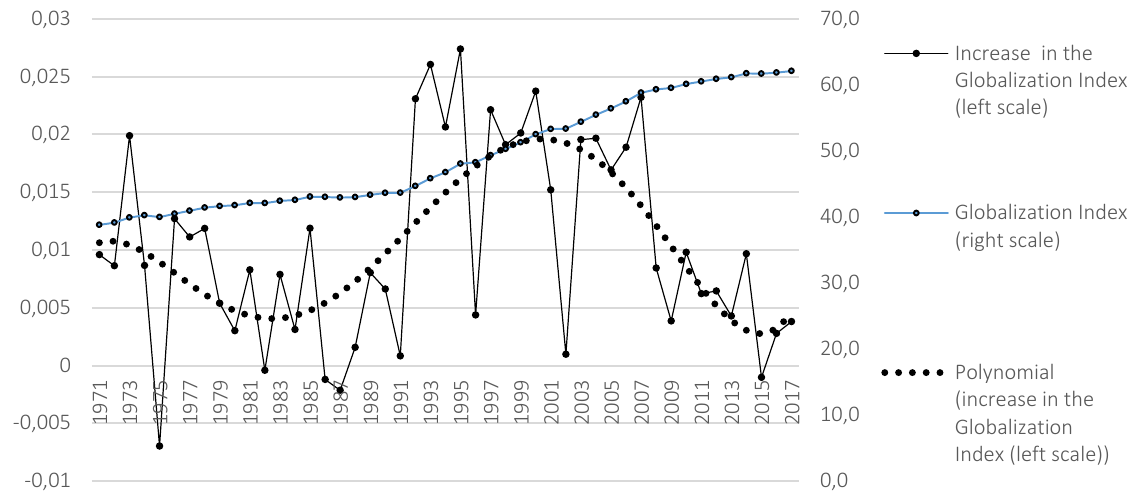
Figure 3. Cyclical development of globalization of the world